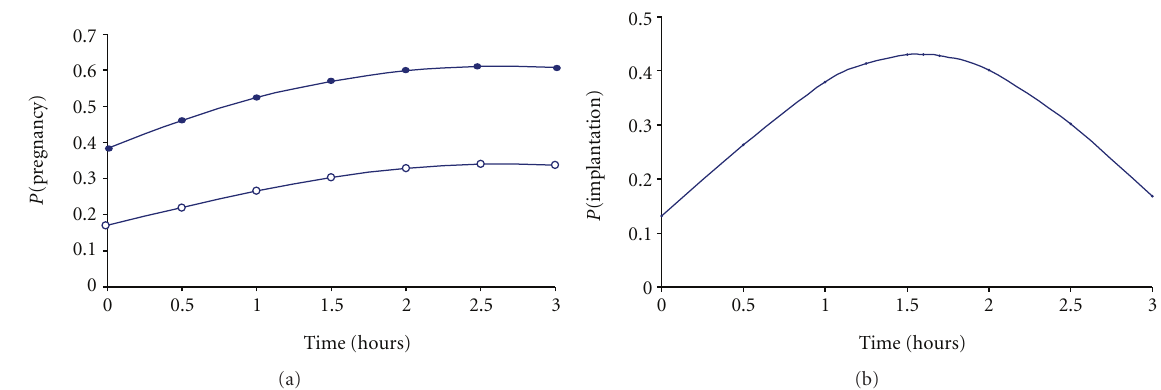
Figure 3: Influence of the timing between oocyte retrieval and denudation on the pregnancy rate (a) and the implantation rate (b). (a) The relation between the probability of pregnancy P (Pregn) and the time between oocyte retrieval and denudation ( T 1 ) follows the equation log( P (Pregn)) / (1 − P (Pregn)) = − 2 . 69 + 0 . 70( T 1 ) − 0 . 13( T 1 ) 2 + 1 . 11 but was not statistically significant ( P values: ( T 1 ): 0.1364, ( T 1 ) 2 : 0.1232). Two curves are represented depending on how many embryos are transferred R = 1 (white circle) if 1 embryo is transferred and R = 2 (black circle) if 2 embryos are transferred. (b) The relation between the probability of implantation P(i) and the time between oocyte retrieval and denudation ( T 1 ) was statistically significant following the equation log( P (i)) / (1 − P (i)) = − 1 . 89 + 2 . 04( T 1 ) − 0 . 65( T 1 ) 2 ( P values: ( T 1 ): 0.03 and ( T 1 ) 2 0.03). The best implantation rate was observed for a time between oocyte retrieval and denudation around 1.5